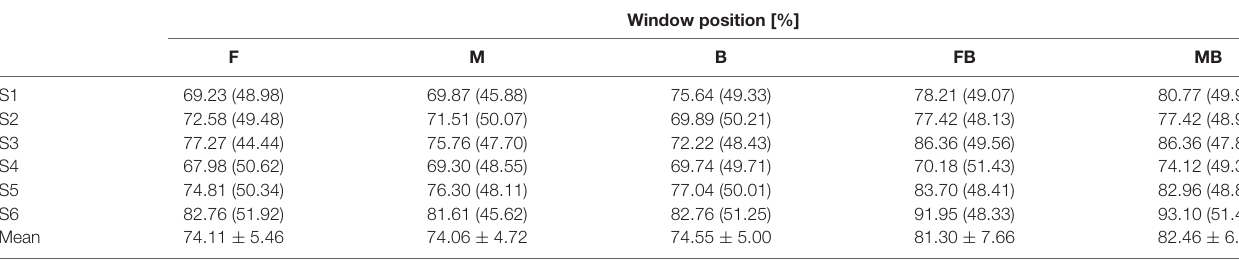
TABLE 4 | Classification accuracies for top vs. bottom